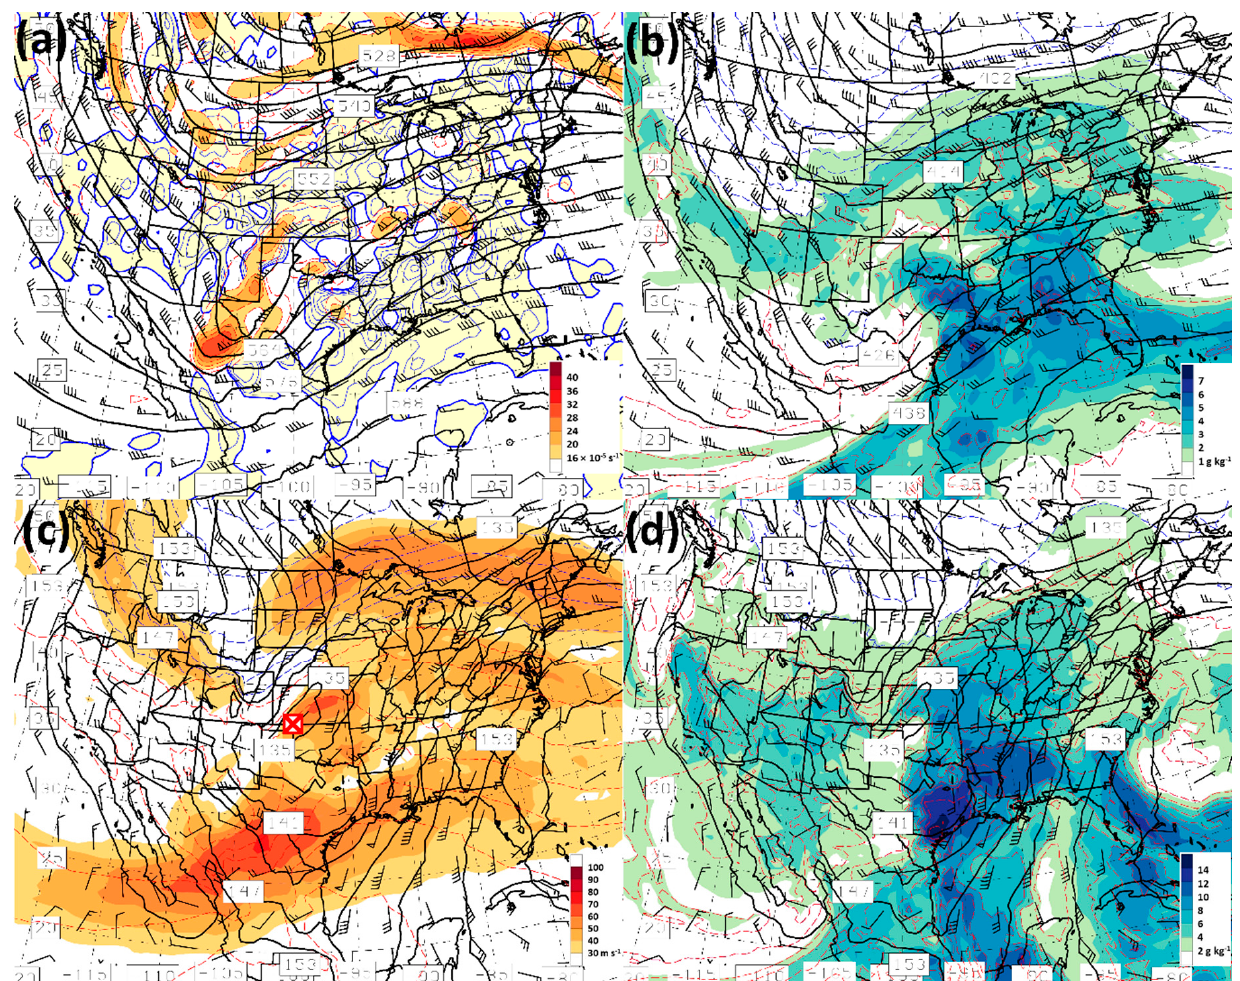
Figure 8. As in Figure 3, except GFS − analyzed fields valid at 1200 UTC 12 April 2020 of: ( a ) 500 hPa level geopotential height (dam, solid black contours), absolute vorticity × 10 − 5 (s − 1 , shading and red dashed contours), and wind vectors (kt) and 700 hPa level rising motion × 10 − 3 (hPa s − 1 , vanilla shading and blue solid contours); ( b ) 600 hPa level geopotential height (dam, solid black contours), mixing ratio (g kg − 1 , shading), equivalent potential temperature (K, final blue (first red) dashed contour value is 304 K (310 K)), and wind vectors (kt); ( c ) 850 hPa level geopotential height (dam, solid black contours) and wind vectors (kt) and 1000-500 hPa layer thickness (dam, final blue (first red) dashed contour value is 540 dam (546 dam)), and 300 hPa level wind speed (m s − 1 , shading); and ( d ) 850 hPa level geopotential height (dam, solid black contours), mixing ratio (g kg − 1 , shading), wind vectors (kt), and equivalent potential temperature (K, final blue (first red) dashed contour value is 280 K (286 K)). Red cross-square symbol in panel ( c ) represents the locally dominant 850 hPa level cyclone center.